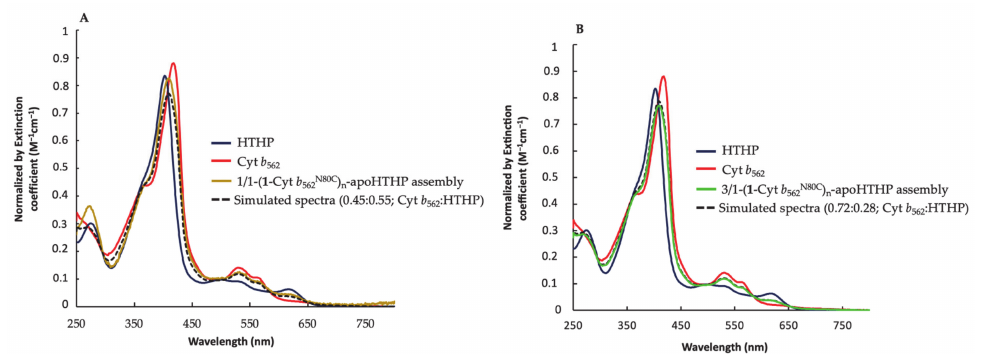
Figure 6. ( A ) UV-Vis spectra of 1/1-( 1 -Cyt b 562N80C ) n -apoHTHP assembly in brown, wild-type HTHP in navy blue and ( 1 -Cyt b 562N80C ) n in red. The simulated spectrum is the dotted black line. ( B ) UV-Vis spectra of 3/1-( 1 -Cyt b 562N80C ) n -apoHTHP assembly in green, wild-type HTHP in navy blue and ( 1 -Cyt b 562N80C ) n in red. The simulated spectrum is the dotted black